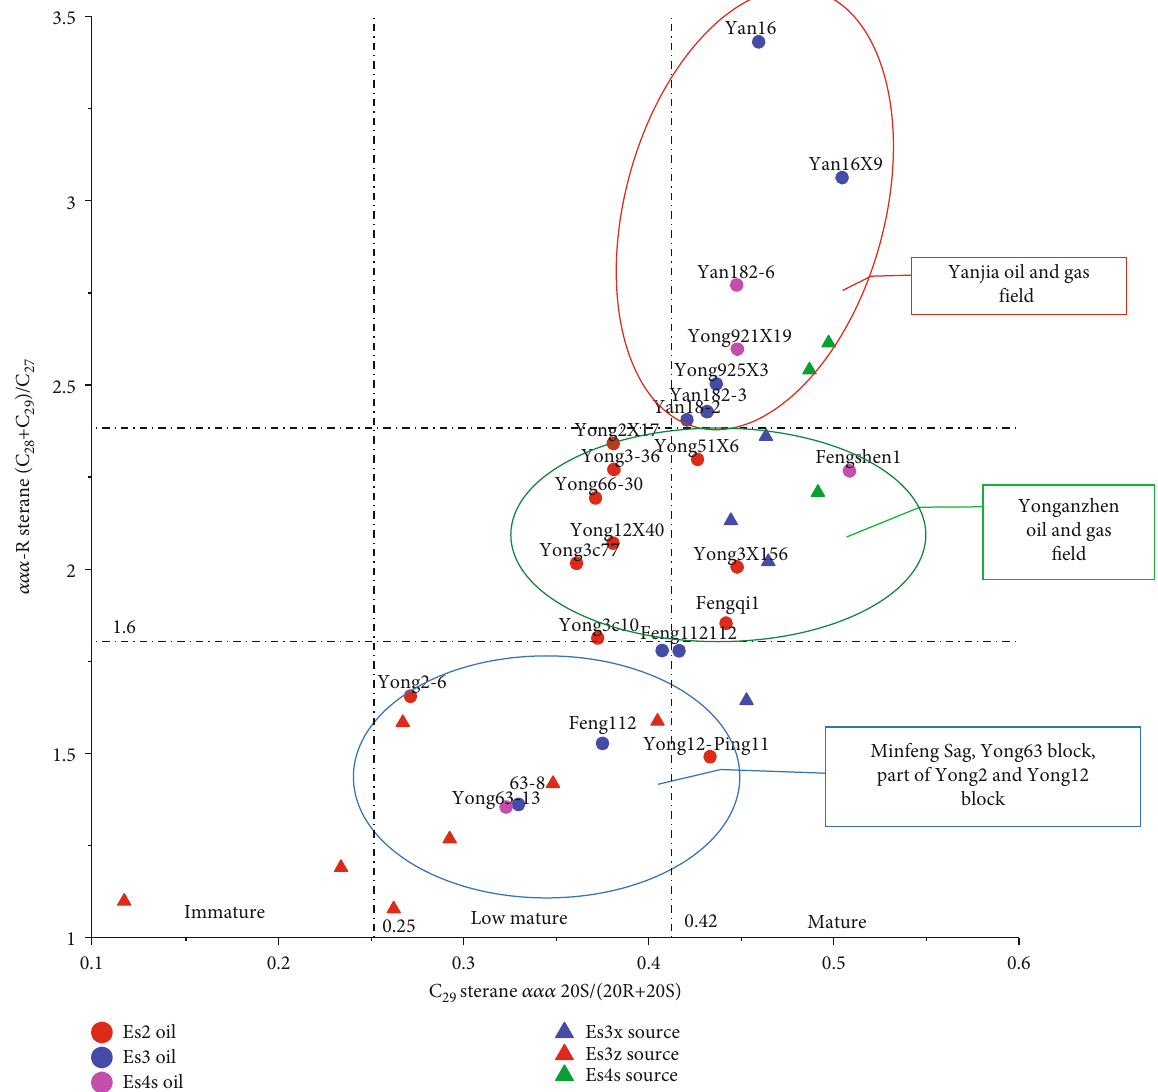
+ C Þ /C 28 29 27 and C 29 sterane